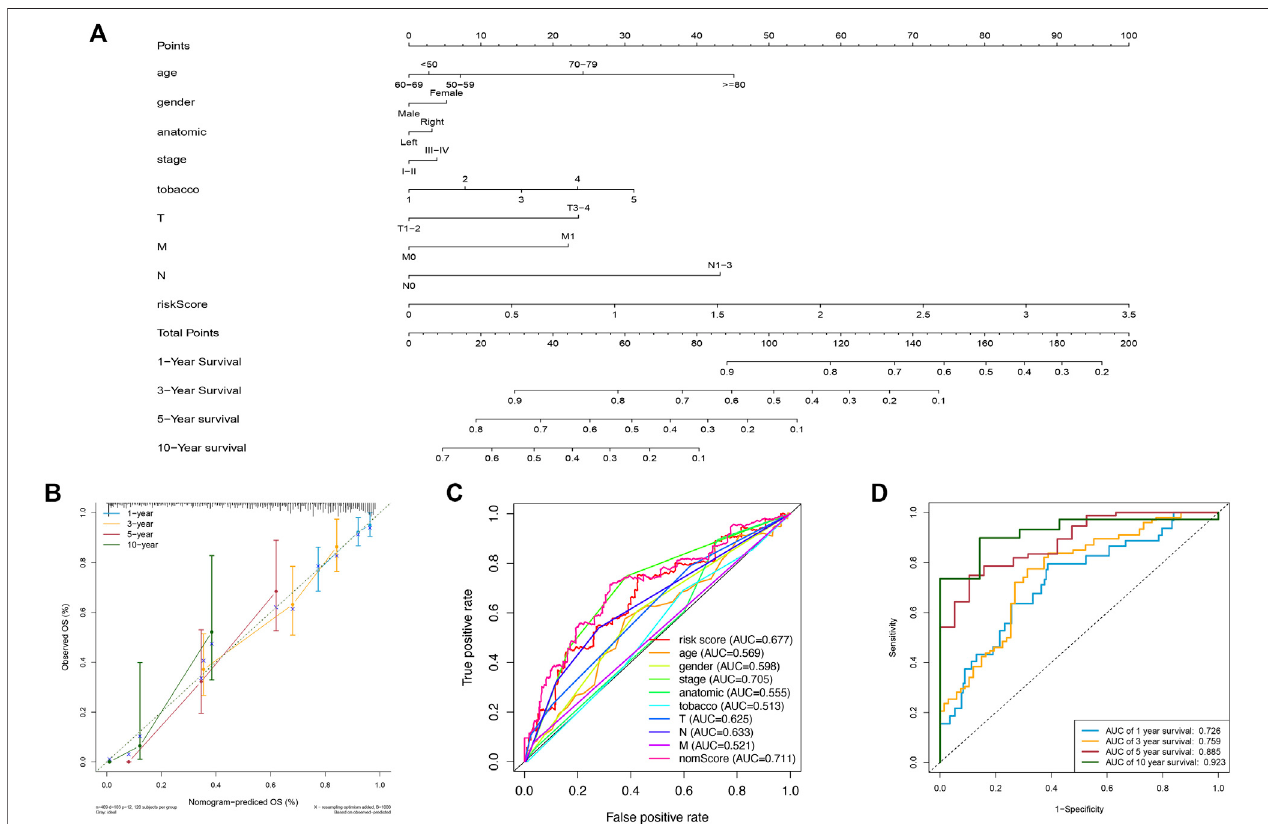
FIGURE 5 | Construction and assessment of a nomogram. (A) The nomogram of 1-year, 3-year, 5-year, and 10-year OS on basis of the risk model and other clinical features. (B) Calibration plots used for evaluating the consistency between the actual and the predicted 1-year, 3-year, 5-year, and 10-year OS. (C) ROC curves forthenomscore(AUC=0.711)andotherelements. (D) TheROCcurvesofnomscoreforpredictingOS.TheAUCof1-year,3-year,5-year,and10-yearOSwere0.726, 0.759, 0.885, and 0.923 respectively.